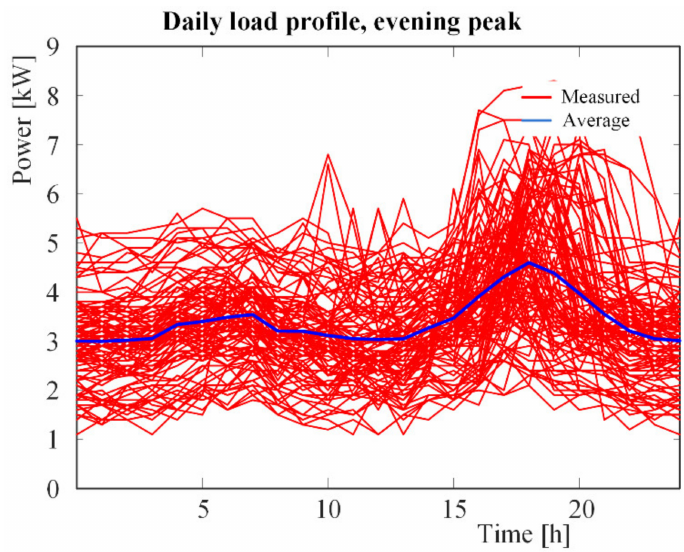
Figure 7. The evening peak consumption pattern.